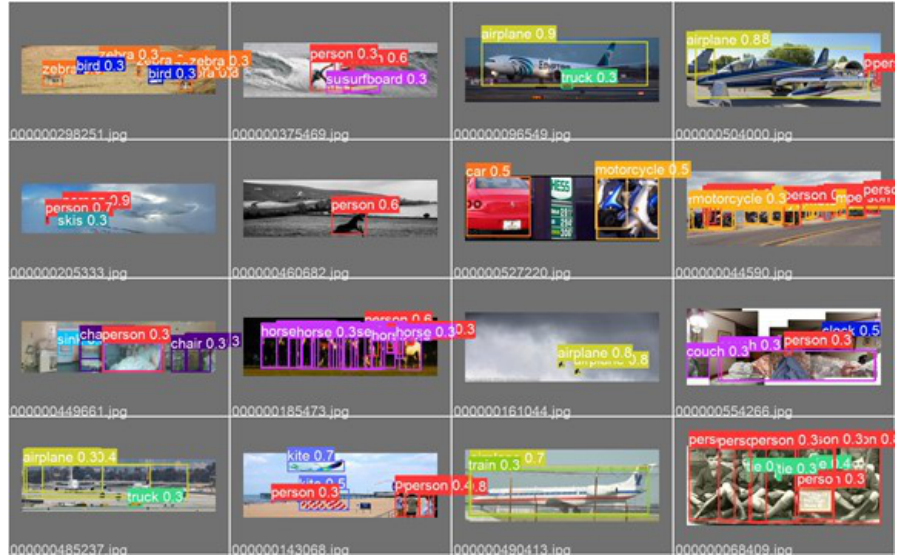
Figure 16. Examples of annotated images in the test set from the COCO and SEAGULL combination— bounding boxes and classes with confidence shown as predicted by the algorithm trained on the combined